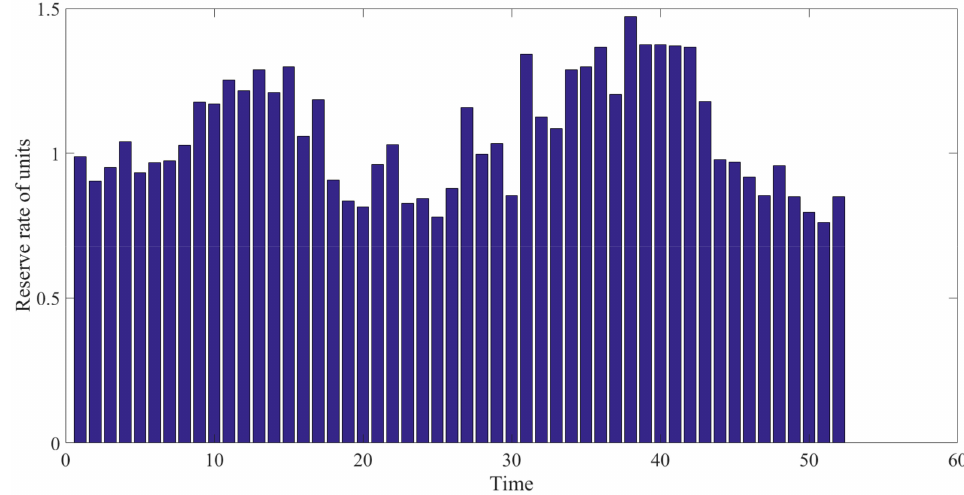
Figure 12. The unit reserve rate of the system.